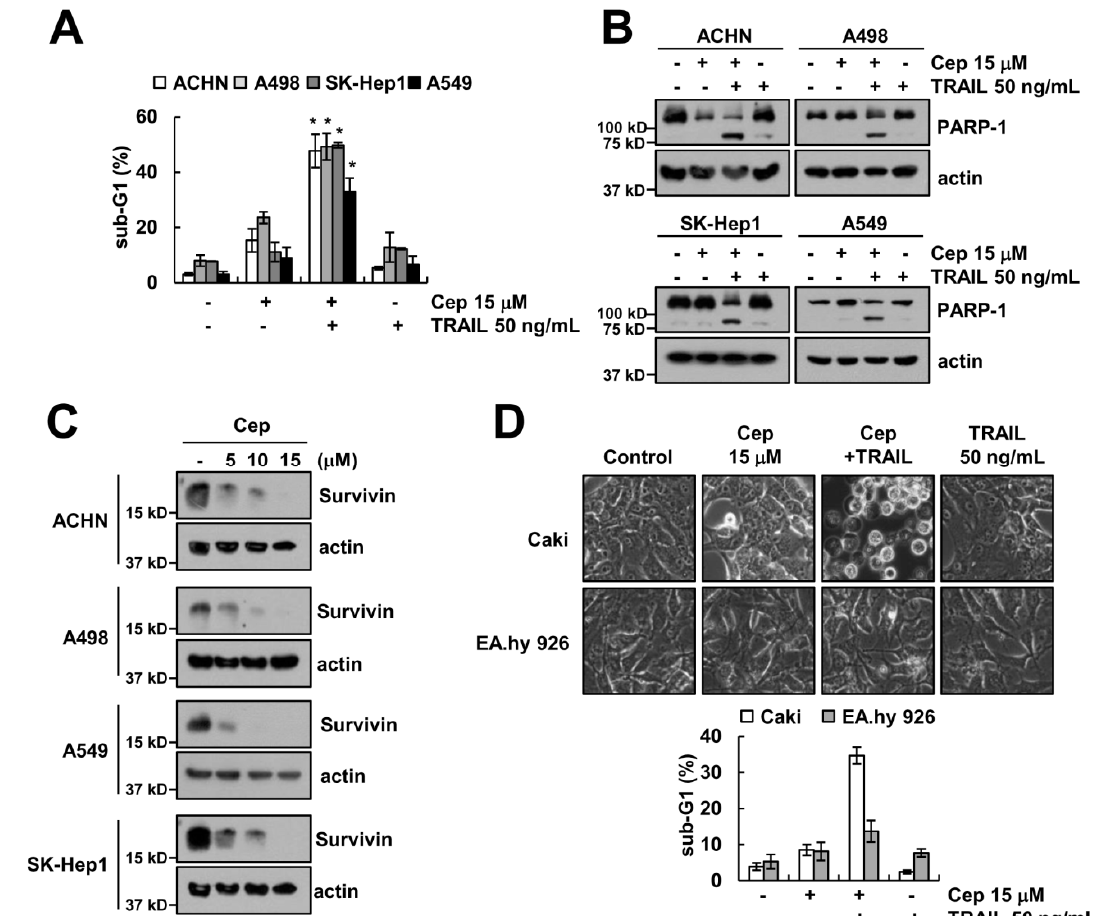
Figure 5. The effects of CEP on TRAIL sensitization in other cancer cells and normal cells. ( A , B ) Caki cells were treated with 15 μM CEP and/or 50 ng/mL TRAIL for 18 h; ( C ) cells were treated with CEP (5–15 μM) for 18 h; ( D ) Caki and normal human umbilical cells (EA.hy 926) were treated with 15 μM CEP and/or 50 ng/mL TRAIL for 18 h. Morphology of cells was detected by interference light microscopy. The sub-G1 population and protein levels were detected by flow cytometry and Western blotting, respectively. Data represent the mean ± SD of at least three independent experiments. * p < 0.05 compared with the control.